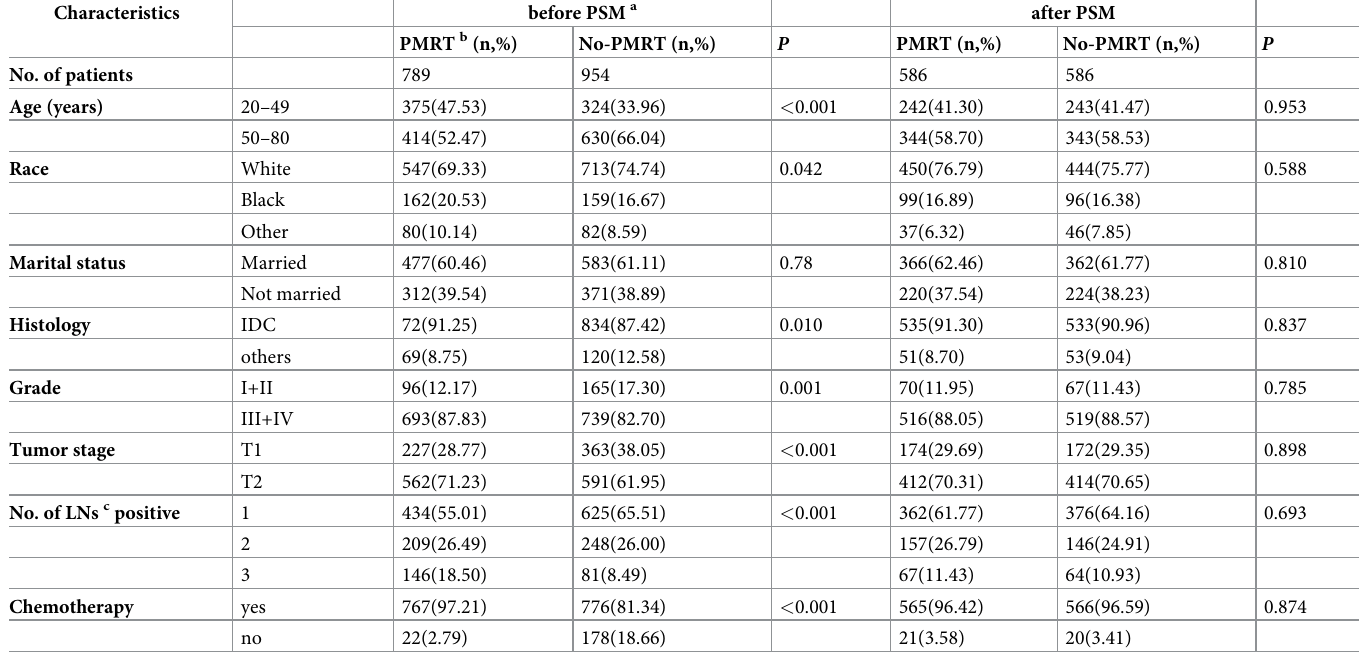
Table 1. Baseline characteristics of the study population and tumor.